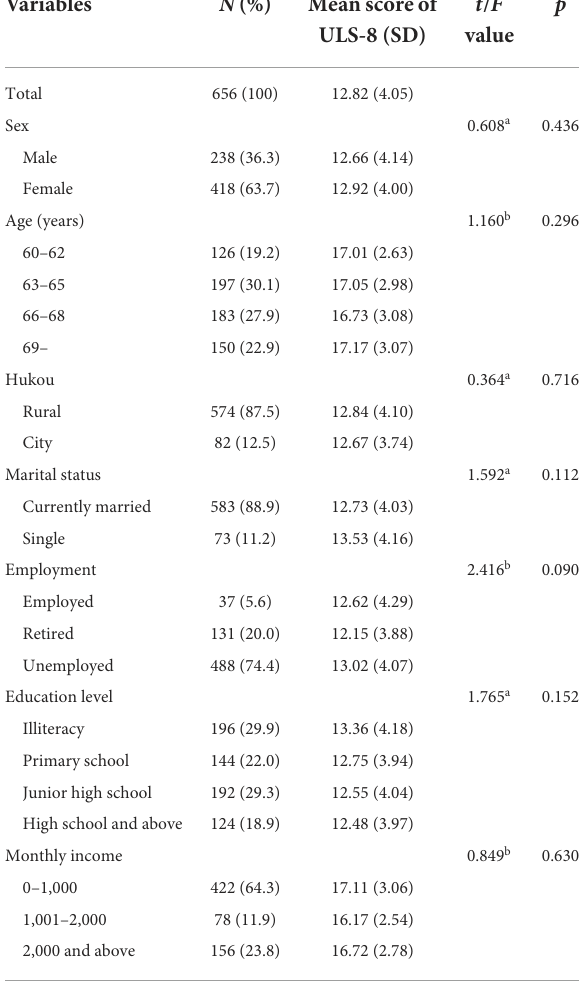
TABLE 1 Demographic characteristics of the